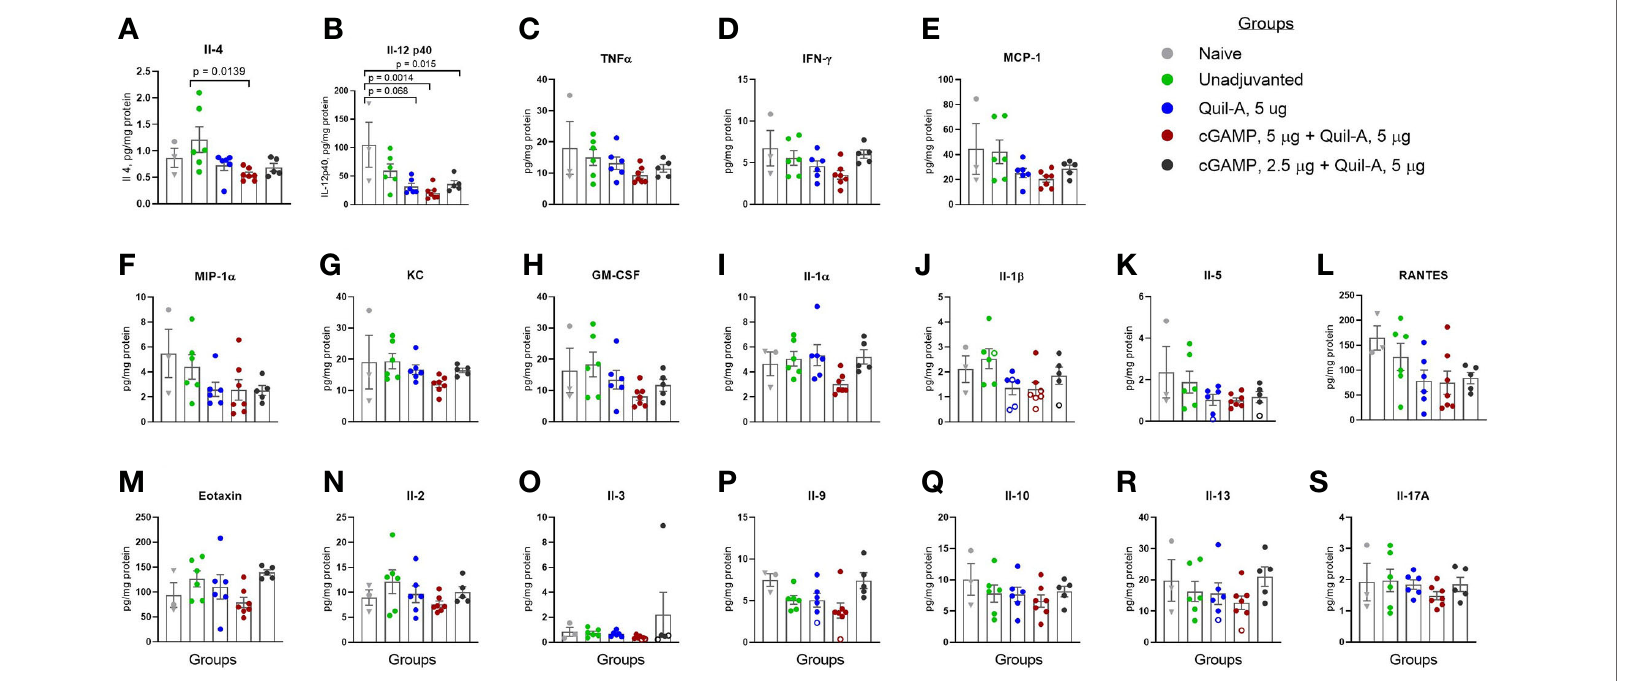
FIGURE 4 | Effect of adjuvant composition of MNPs on the levels of cytokines and chemokines in lung lysates of the aged mice that survived the challenge. The lungs from all vaccinated mice and one naive mouse were collected on day 13 postchallenge (circles), and from the remaining two naïve mice on day 16 postchallenge (triangles). The open circles represent data extrapolated below standard range. (A) IL- 4; (B) IL-12 (p40); (C) TNF a ; (D) IFN- g ; (E) MCP-1; (F) MIP-1 a ; (G) KC, (H) GM-CSF; (I) IL- 1 a ; (J) IL-1 b ; (K) IL- 5; (L) RANTES; (M) Eotaxin, (N) IL- 2, (O) IL- 3; (P) IL- 9; (Q) IL- 10, (R) IL- 13, (S) IL- 17A. Groups: Grey – naïve, n = 3; green – unadjuvanted vaccine MNP, n = 6; blue – vaccine adjuvanted with Quil-A, 5 m g MNP, n = 6; red – vaccine adjuvanted with cGAMP, 5 m g + Quil-A, 5 m g MNP, n = 6; black – vaccine adjuvanted with cGAMP, 2.5 m g + Quil-A, 5 m g MNP, n = 6. The statistical signi fi cance between groups was calculated by one-way ANOVA with Tukey ’ s